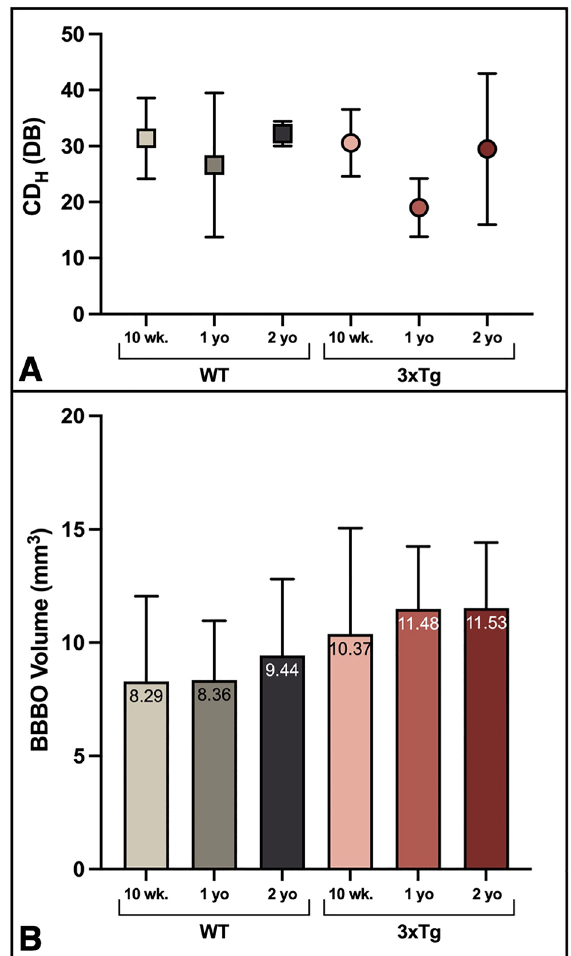
Figure 2. Age and AD produce trending increase in BBBO volume with consistent stable harmonic cavitation dose. ( A ) The mean stable harmonic cavitation dose (CD H ) delivered to each group is shown. No significant differences were detected between groups ( P > 0.05, one-way ANOVA with multiple comparisons). ( B ) The average initial BBBO volume for each cohort is shown. Differences between groups are not significant ( P > 0.05, one-way ANOVA with multiple